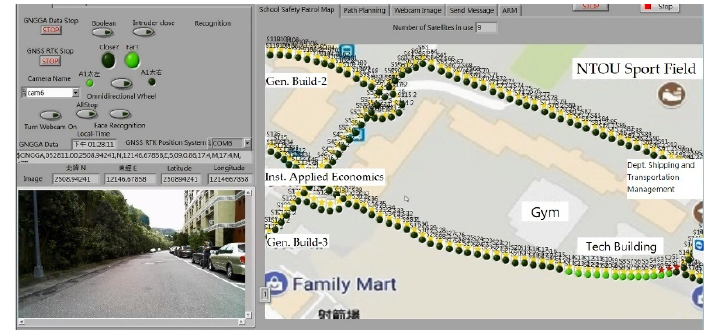
Figure 22. The robot started patrolling according to the path planning on the map.